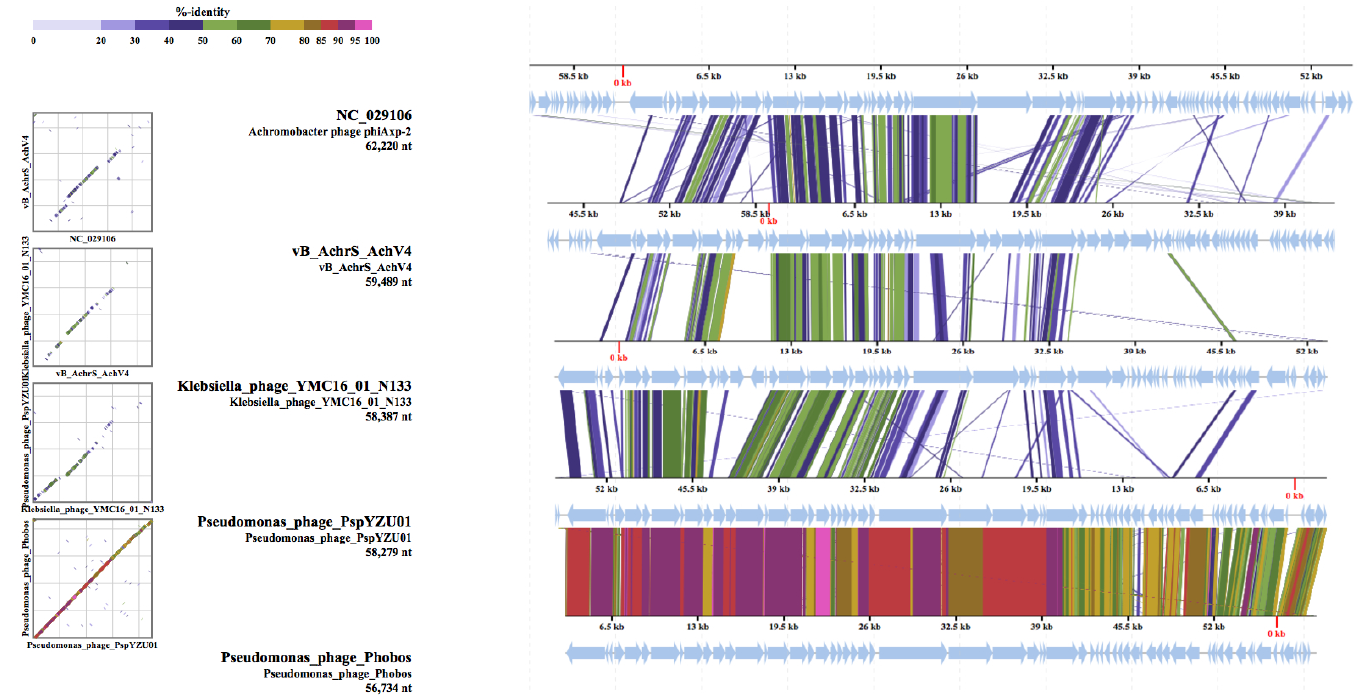
Figure 6. Genome alignment of AchV4, phiAxp-2, Phobos, PspYZU01, and YMC16/01/N133_KPN_BP. All tBLASTx alignments are represented by colored lines between two genomes. Color scale represents the tBLASTx percent identity. The figure was generated by ViPTree.